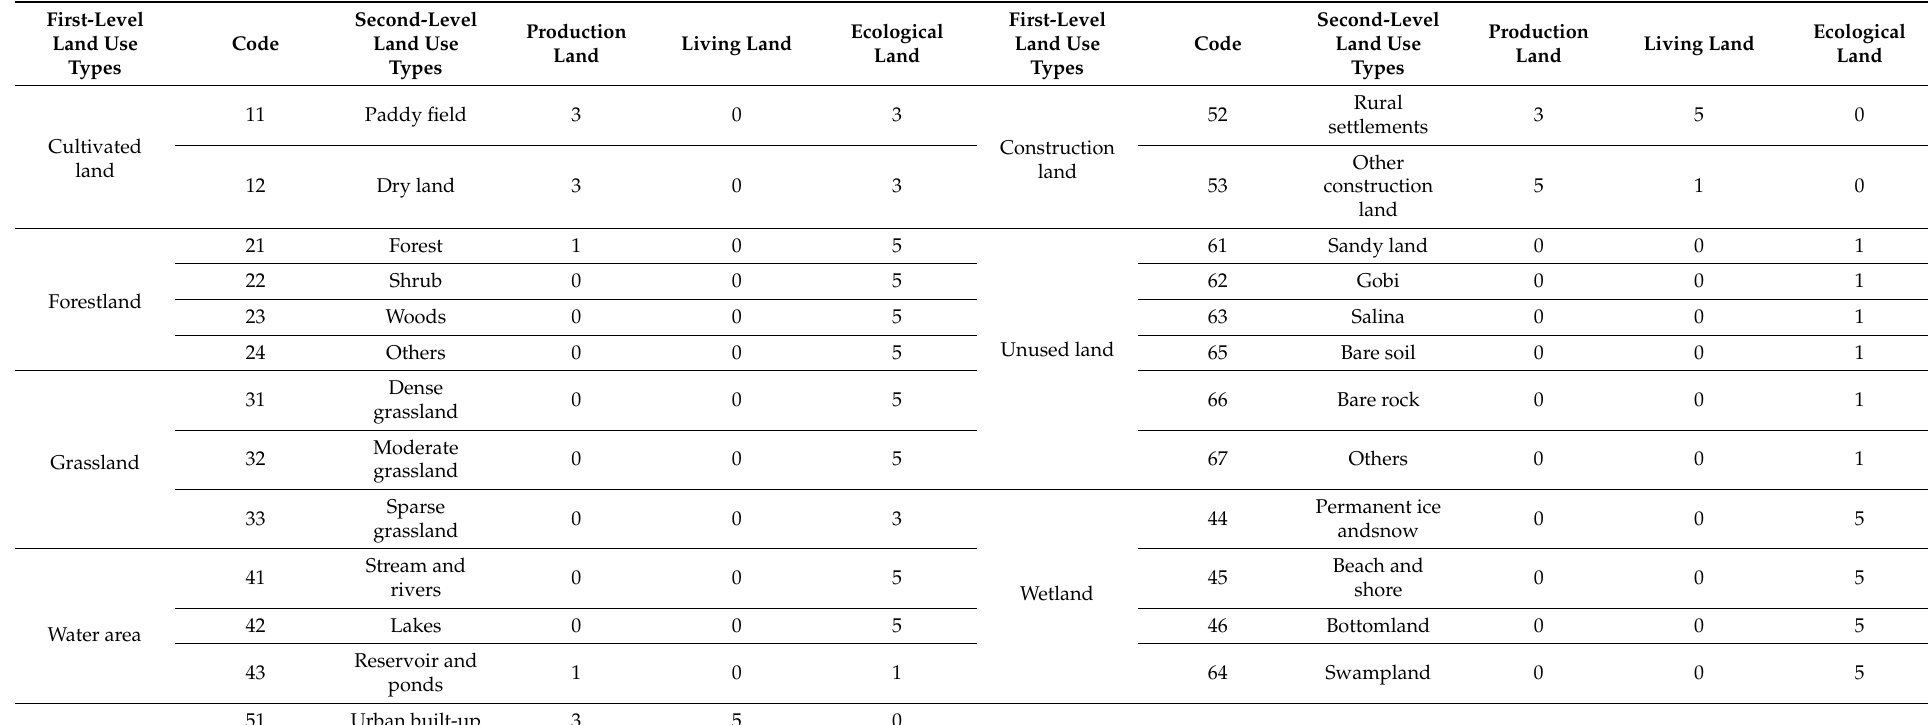
Table 1. Land use classification and assessment of